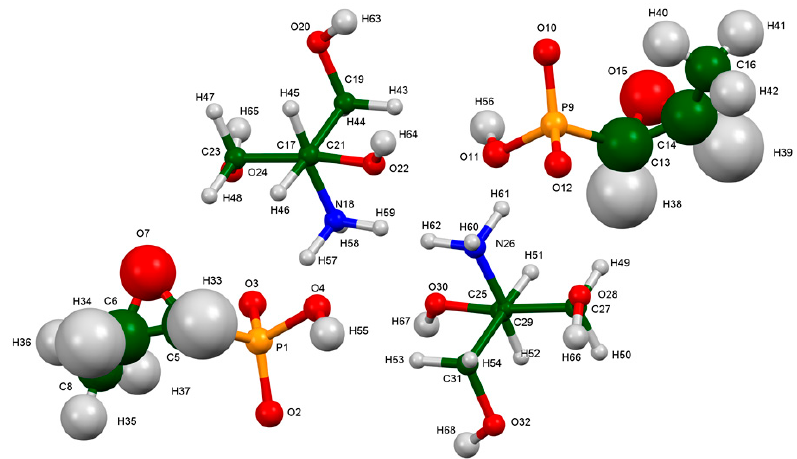
Figure 4. The asymmetric unit of fosfomycin tromethamine, with the atom numbering. The atoms are represented by 50% probability spheres.